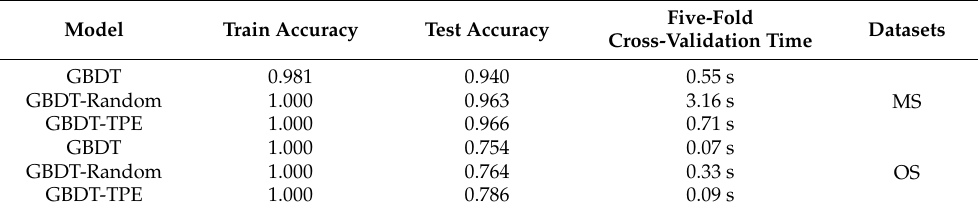
Table 5. The result of five-fold cross-validation for GBDT